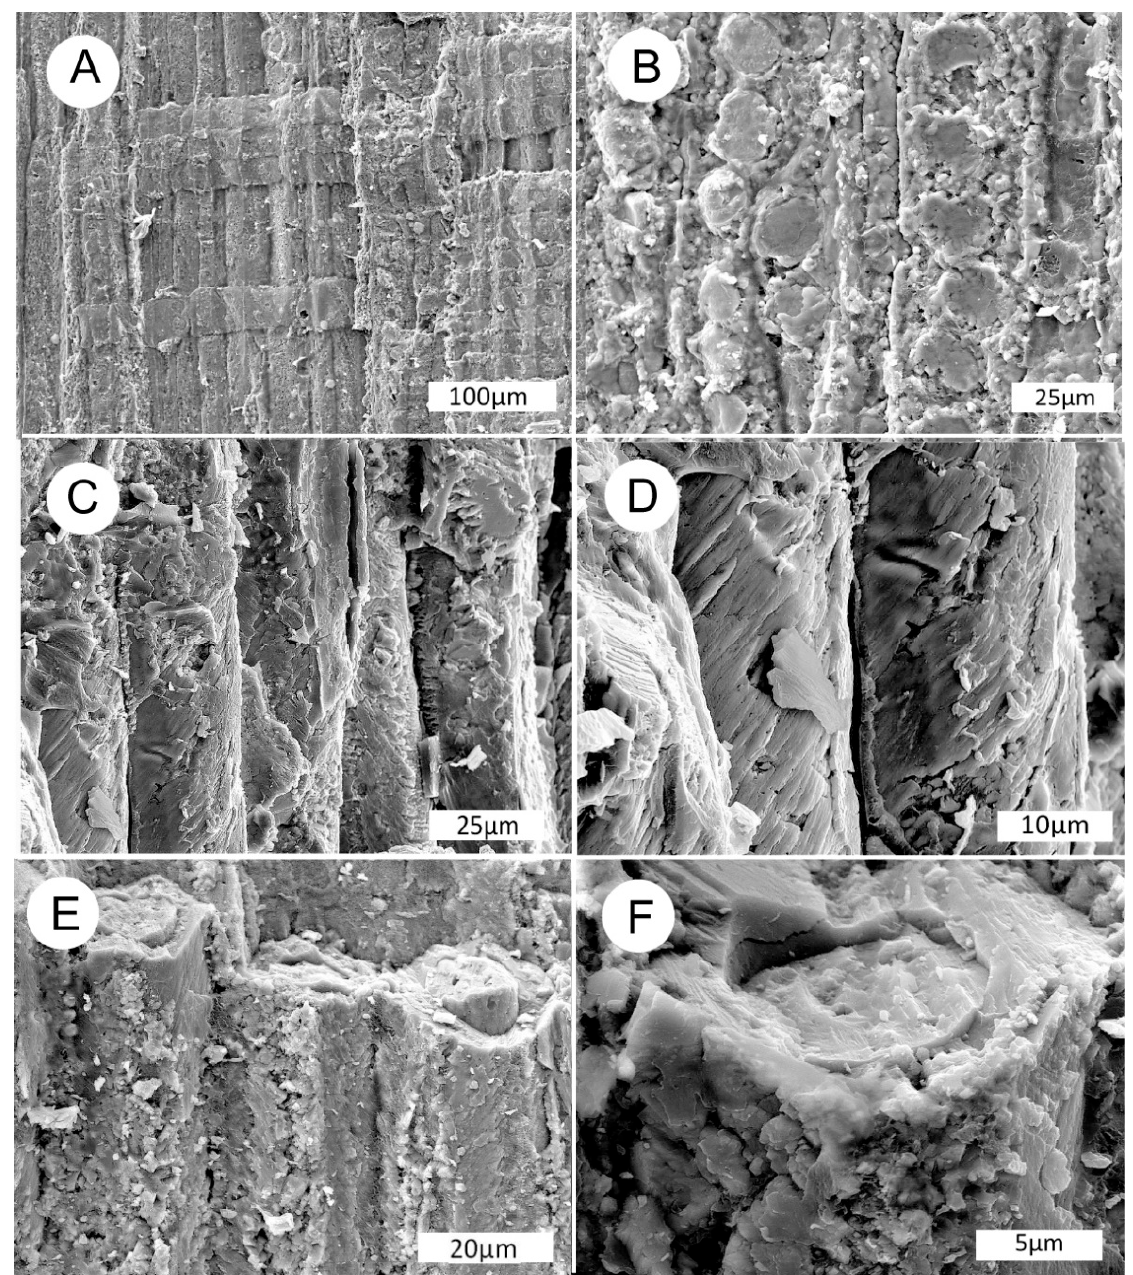
Figure 6. SEM images of calcite-mineralized wood. ( A ) Apple Bay wood (Lower Cretaceous) showing vertical tracheids and horizontal ray cells. ( B ) Apple Bay wood, radial view showing mineralized casts of circular intervessel pits. ( C ) Port Hardy wood (Upper Cretaceous), tracheid cells in radial view. ( D ) Port Hardy wood, showing mineralized cell walls. ( E ) Puntledge River wood (Upper Cretaceous), oblique radial view. ( F ) Puntledge River wood, oblique view of a tracheid with calcite permineralized cell walls, and lumina filled with crystalline